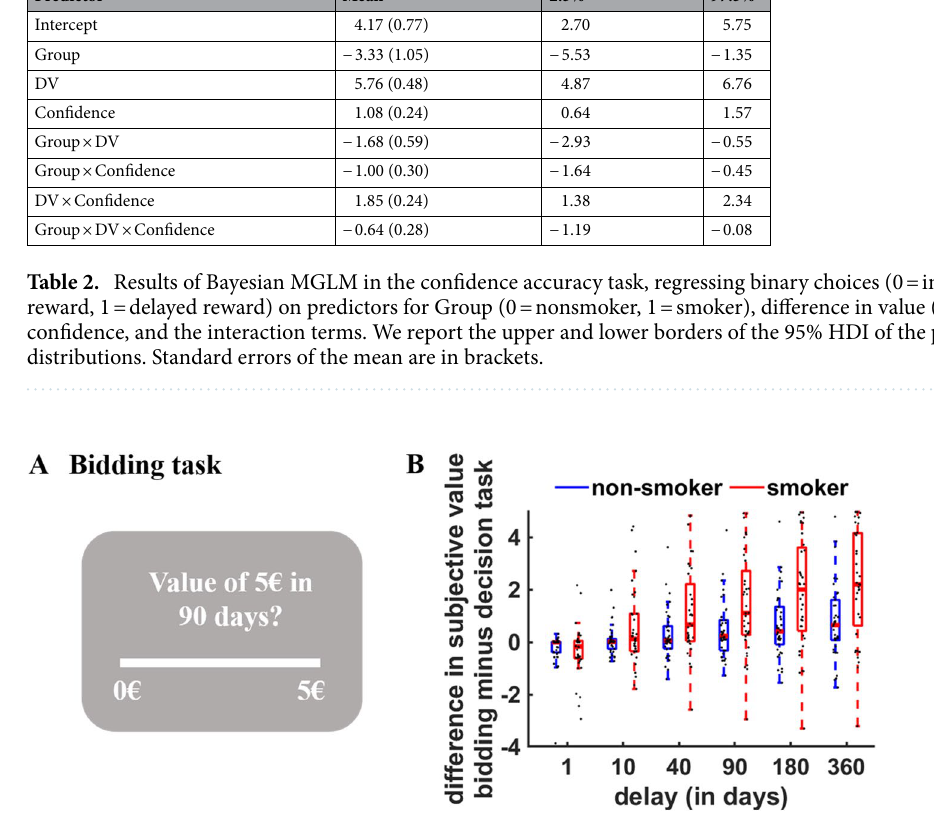
Figure 2. ( A ) In the bidding task, participants indicated which immediate reward magnitude they consider as equivalent to a given reward delivered in the future on a rating scale from 0 to 5 euro. The difference between subjective reward values estimated from observed choices in the confidence accuracy task (via individual hyperbolic discount parameters) and the self-reported values from the bidding task reflects the degree to which individuals over- or underestimate the value of future rewards relative to their revealed preferences. ( B ) Smokers, relative to non-smokers, overestimate their preferences for delayed over future rewards, particularly for longer delays, as indicated by higher self-reported than observed subjective values. Black dots indicate individual data